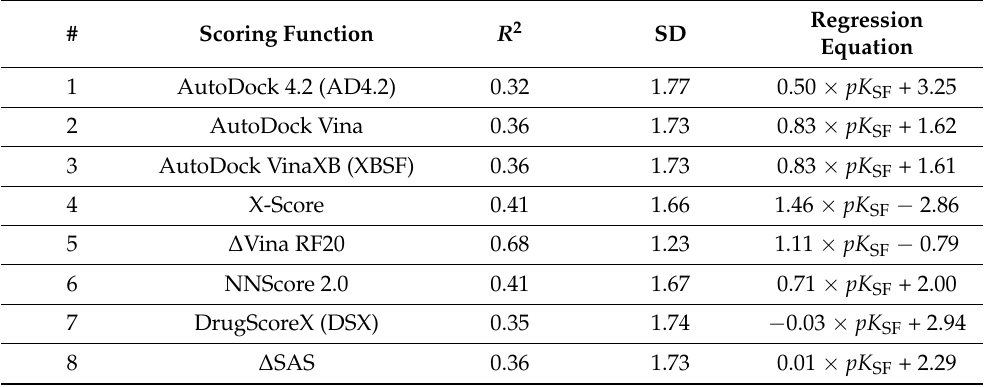
Table 3. Statistical characteristics of linear correlation of the predicted pK SF values with the reference pK values.